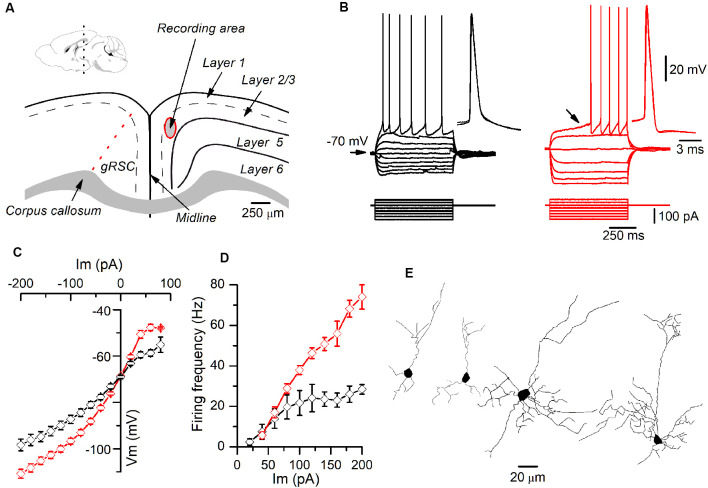
Different firing patterns of layer 2/3 pyramidal neurons recorded in the granular retrosplenial cortex (GRSC). (A) Coronal view of the mouse GRSC highlighting the recording area. The dotted red line shows the approximate limit between the GRSC and the dysgranular RSC; this limit has been set according to Vogt and Paxinos (2014). The inset shows the mid-sagittal mouse brain with the approximate level of the coronal slices used for recordings (black dotted line; drawing taken from https://portal.brain-map.org/, reference atlas version 1, 2008; available online at: http://connectivity.brain-map.org/; 2014 Allen Institute for Brain Science). (B) Responses to hyperpolarizing and depolarizing current pulses of two pyramidal neurons recorded in layer 2/3 of the GRSC. The left panel (black traces) shows the regular spiking firing found in some neurons; the right panel (red traces) shows the late spiking firing pattern. Insets: two superimposed action potentials shown on larger time scales. The black arrow in the right panel shows the slow subthreshold depolarization that characterized the late-spiking (LS) firing pattern. Scale bars on the right also apply to the left panel. (C) I/V relationship of non-LS (black symbols; n = 5–16) and LS pyramidal neurons (red symbols; n = 9–20). (D) firing frequency vs. injected current measured in non-LS (black symbols; n = 5–16) and LS pyramidal neurons (red symbols; n = 5–16). The firing was evoked by square depolarizing current pulses as shown in panel B; the firing frequency was averaged throughout the firing in both LS and non-LS neurons. (E) Neurolucida drawings of two LS (left) and two non-LS neurons (right).